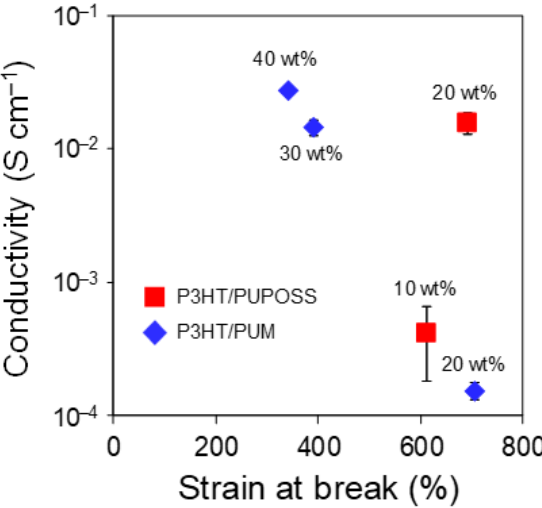
Figure 5. Correlations between conductivity and strain at break of P3HT/PUPOSS and P3HT/PUM at each amount of loaded doped P3HT.